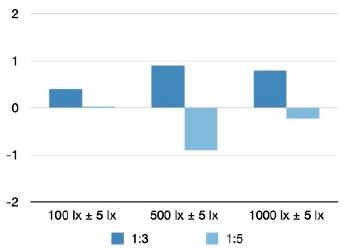
Figure 10. Histogram of starting illuminance and comfort